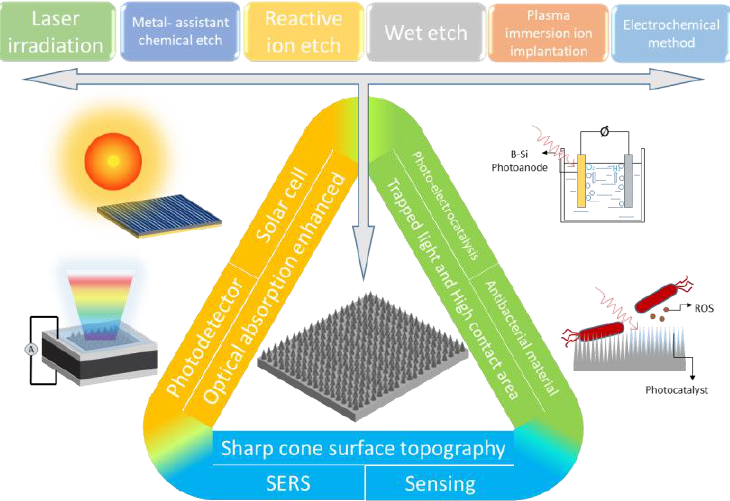
Figure 2. A figure overview of this review .